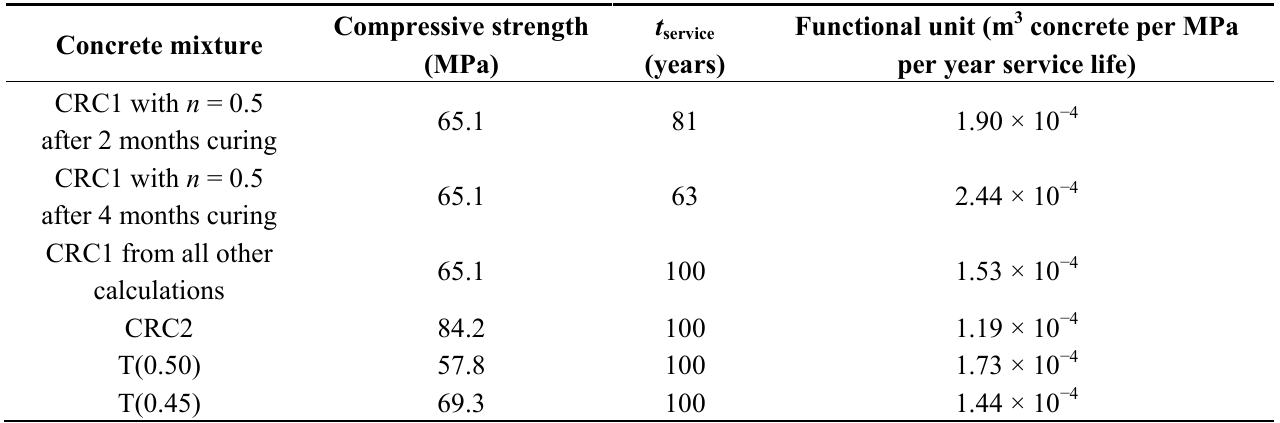
Table 2. Overview of the calculated Functional